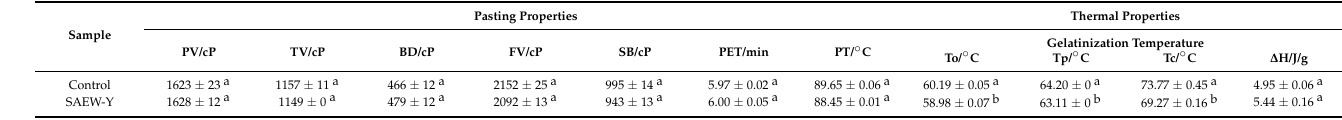
Table 3. Pasting parameters and thermal properties of the control and SAEW tempering flour samples.